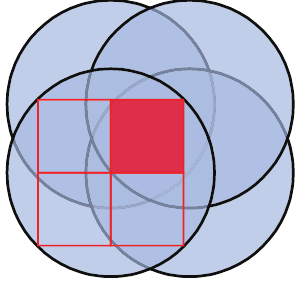
Figure 2. Top view of four base-station signal coverage